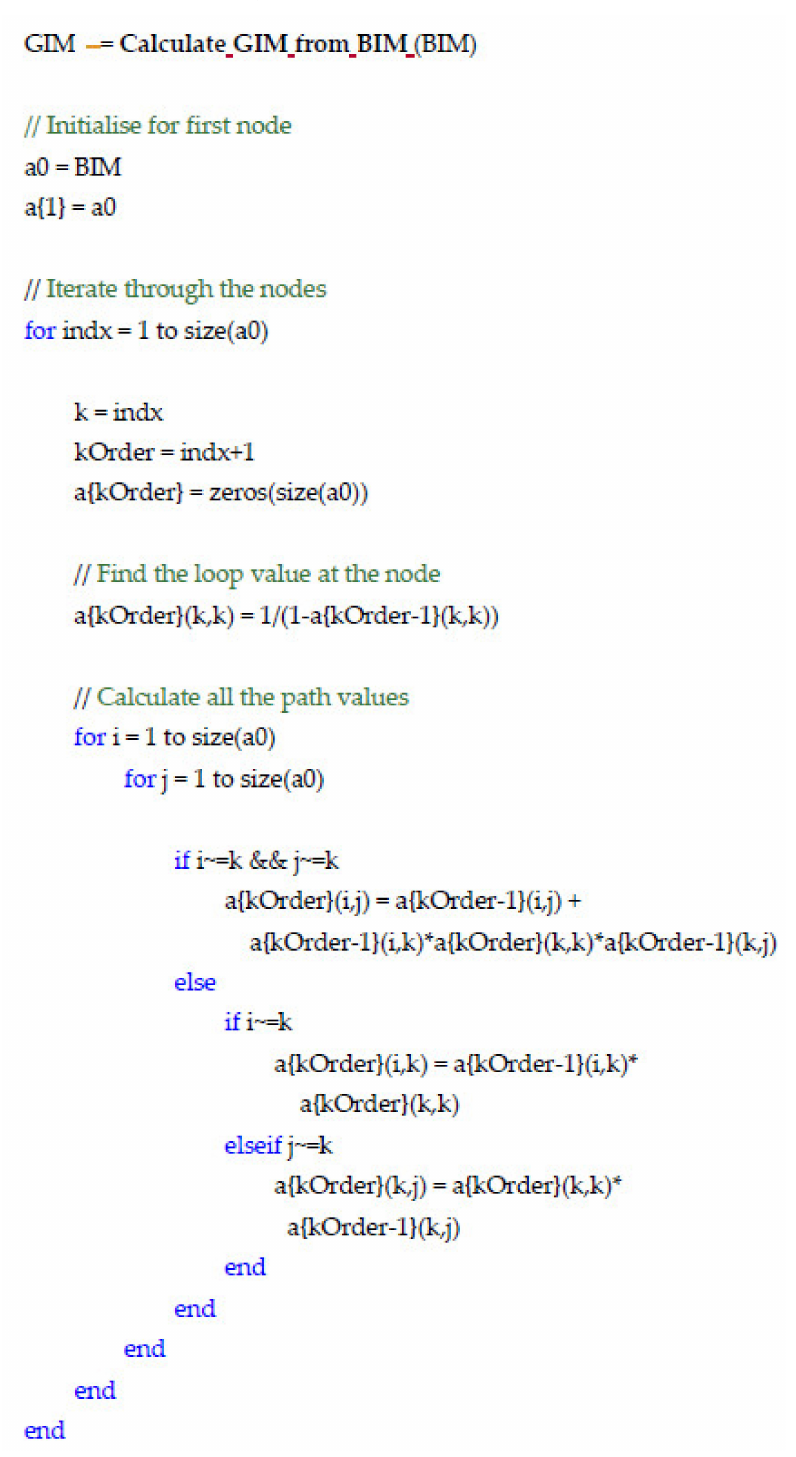
Figure 4. ( Top ) Comparison of binary interact matrix (BIM) and global interaction matrix (GIM) for a two-parameter problem; ( bottom ) pseudocode for generation of the GIM. Unlike typical neural networks, the structure comprises a single 2D grid of neurons. Nodes are directly connected to input data but not each other. The weights of